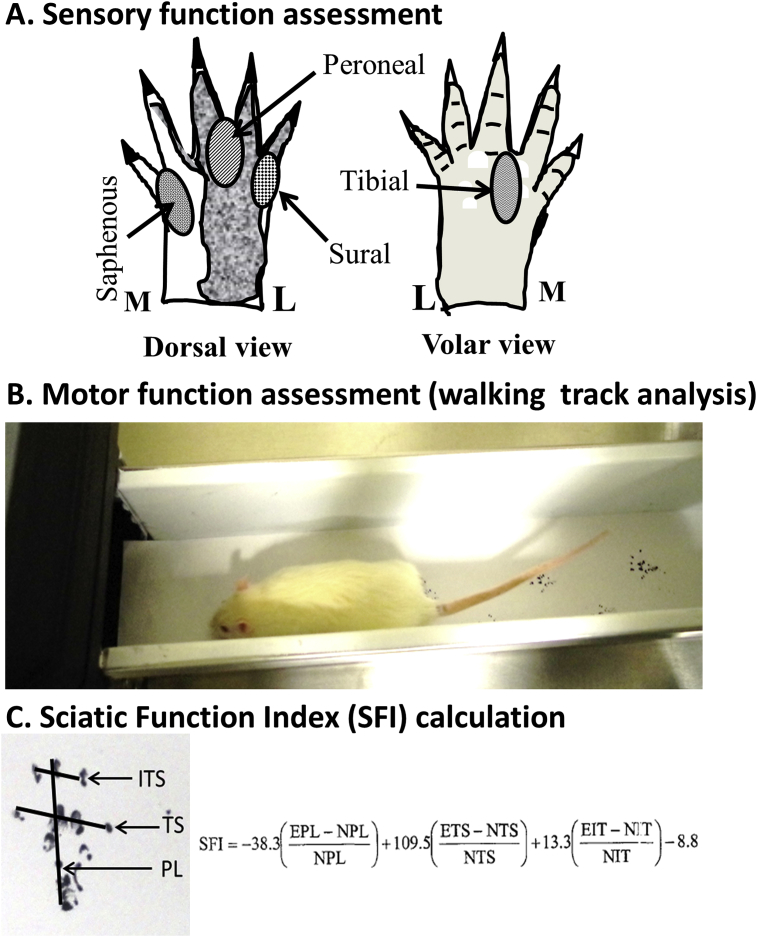
Limb functional analysis. A. Sensory function assessment (Cutaneous Pain Reaction Test): Sensory function was assessed by pinch technique in the territories of the tibial (T), peroneal (P), sural (Sur), and saphenous (S) nerves as described, previously [39, 40]. Withdrawal/vocal response was scored in comparison to the normal limb (0 = no response, 1 = slight, 2 = moderate, 3 = normal). L, Lateral; M, Medial. B, Motor function assessment (Walking Track Analysis): Progression of walking track of naive and nerve transected/repaired limb foot-prints were obtained on a paper in a rat walking apparatus as described previously [39, 45–48] C, Sciatic Function Index (SFI) was calculated from the following foot-print measurements (mm): EPL, Experimental plantar length; NPL, Normal plantar length; ETS, Experimental toe spread; NTS, Normal toe spread; EIT, Experimental intermediary toe spread; NIT, Normal intermediary Toe Spread; PL, Plantar length (distance between heal to middle 3rd toe); TS, Toe spread (distance between 1st and 5th toe); IT, 2nd and 4th toe distance; ITS, Intermediary toe spread.